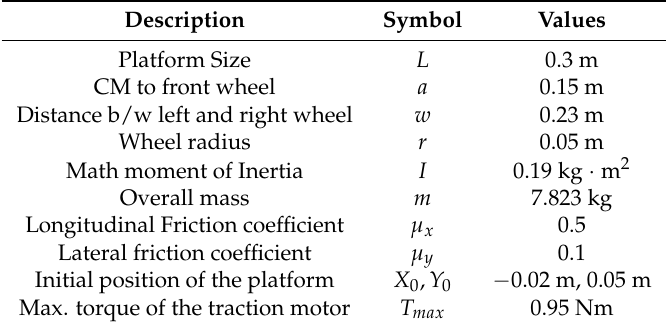
Table 1. Summary of modeling parameters in the numerical